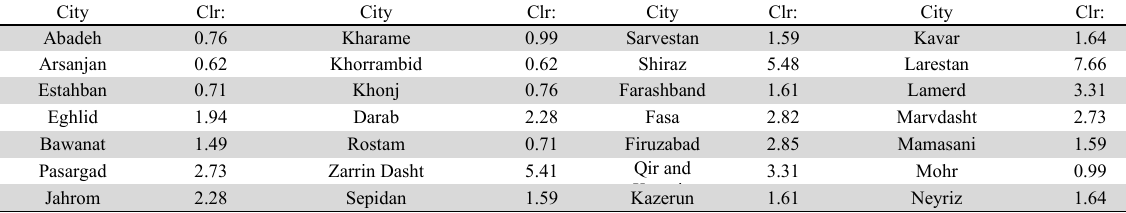
Determining the homogeneous groups